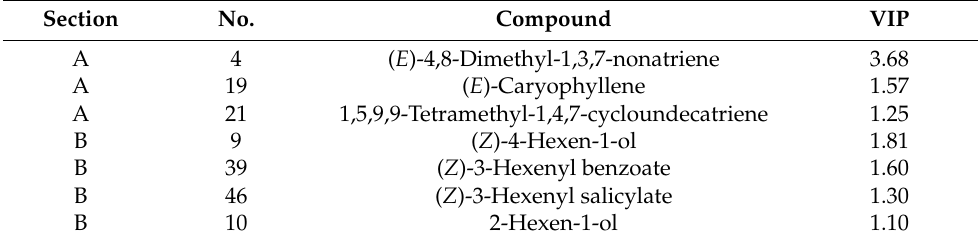
Table 3. Differential volatile compounds between female and male buds of T. anguina .